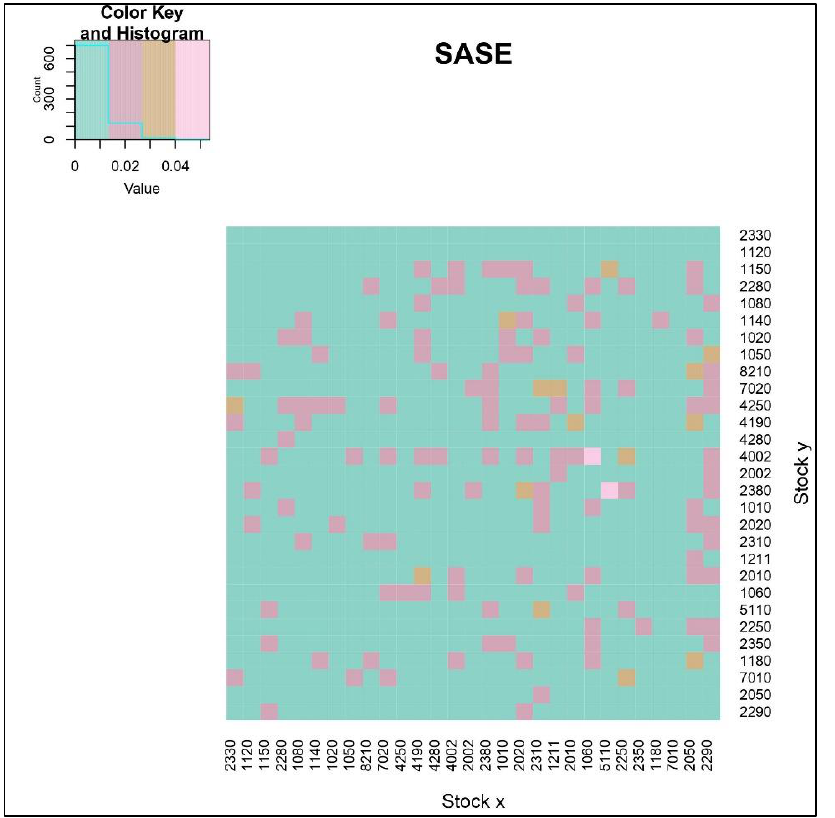
Figure 18. The information flow (effective transfer entropy) from stock y to stock x, for the top companies (by market capitalization) in the SASE market, after the COVID-19